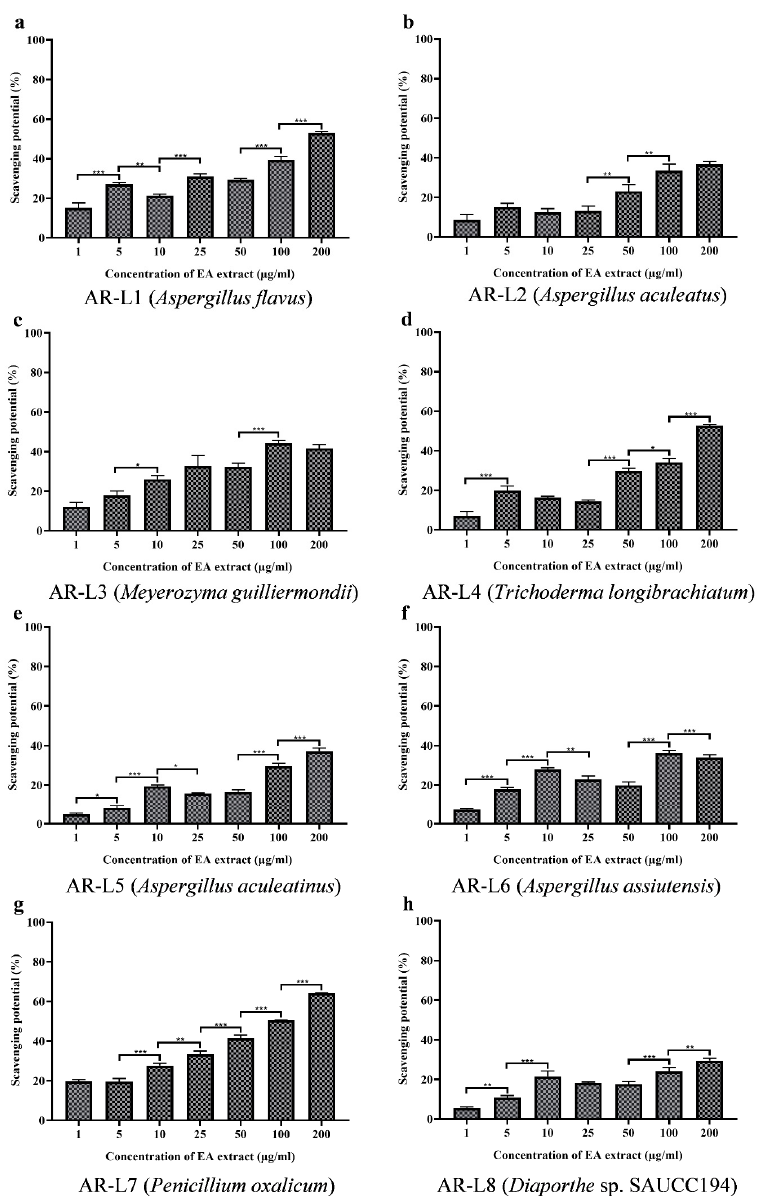
Figure 3. DPPH free radical scavenging potential of EA extract of fungal endophytes ( a ) A. flavus , ( b ) A. aculeatus , ( c ) M. guilliermondii , ( d ) T. longibrachiatum , ( e ) A. aculeatinus , ( f ) A. assiutensis , ( g ) P. oxalicum and ( h ) Diaporthe sp. SAUCC194. All the experiments were performed in triplicate. p -value was calculated by comparing means ± SD of the DPPH free radical scavenging potential (%), using one-way ANOVA followed by Tukey to determine statistical significance which are as follows; *** p ≤ 0.001; ** p ≤ 0.002; * p ≤ 0.033.